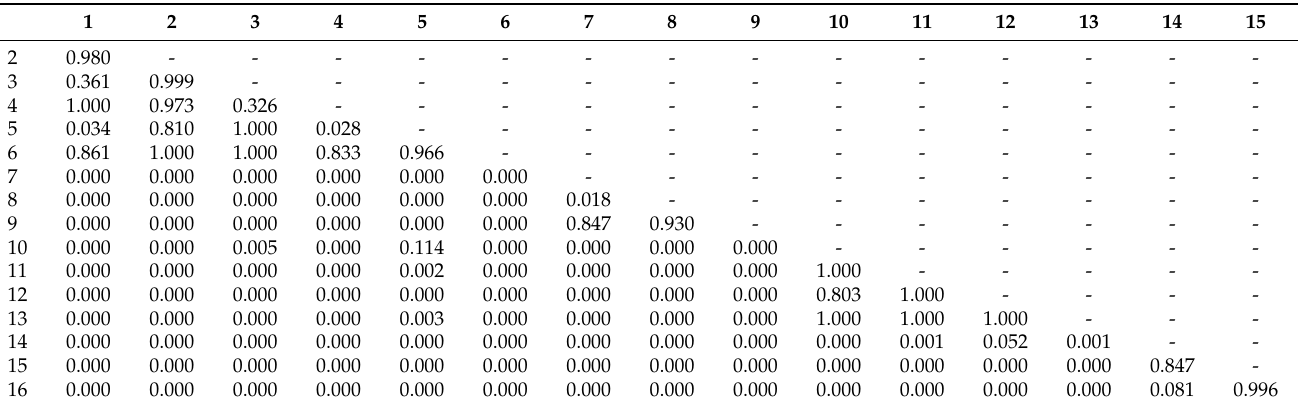
Table A4. p -values obtained from the Nemenyi test applied to the FSIM results. Row/Column names are listed in Table A2.